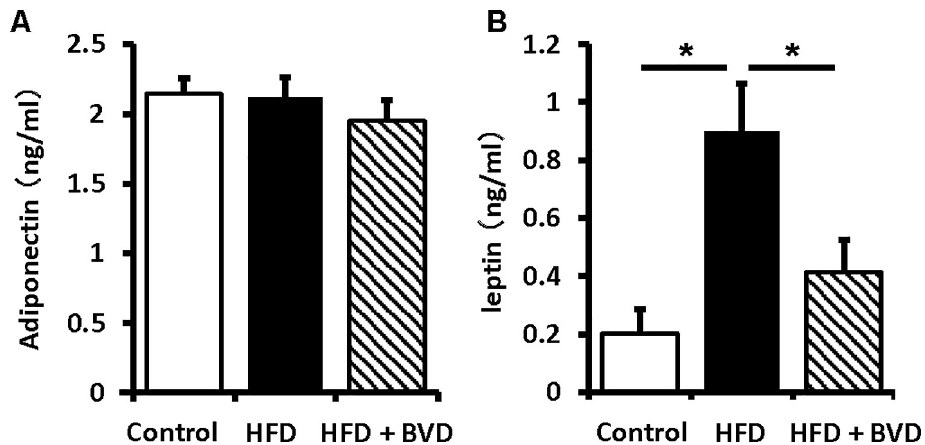
Fig 4. Serum concentrations of adiponectin and leptin. Control mice (open bars), high-fat diet (HFD)-fed mice (closed bars) and HFD mice treated with biliverdin (BVD) (hatched bars). Results are expressed as means ± SEM (n = 8). � P < 0.05 (ANOVA).